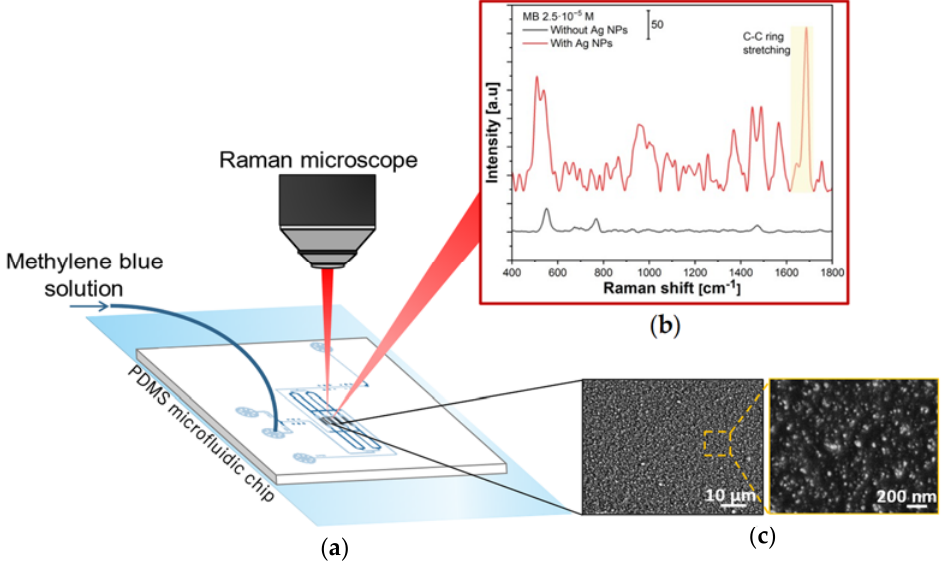
Figure 6. ( a ) Schematic representation of the acquisition of the Raman signals from a PDMS chip with Ag NPs deposited in its chambers. ( b ) Raman spectra of MB obtained by focusing the laser beam on areas of the chip chambers without (in black) and with Ag NPs (in red) deposited on the PDMS. The black curve only shows the PDMS peaks, while the red curve represents MB peaks. In both cases, the fluorescence background was subtracted. The highlighted peak refers to C-C stretching and it was used for the enhancement calculation. The additional MB characteristic peaks and vibrational modes are reported in Figure S5. ( c ) SEM images of Ag NPs deposited on PDMS. Voltage/current settings used for the deposition, V = 1.3 kV and I = 10 mA, respectively, speed of printing of 60 μ m/s, and nozzle ‐ substrate distance of 500 μ m.